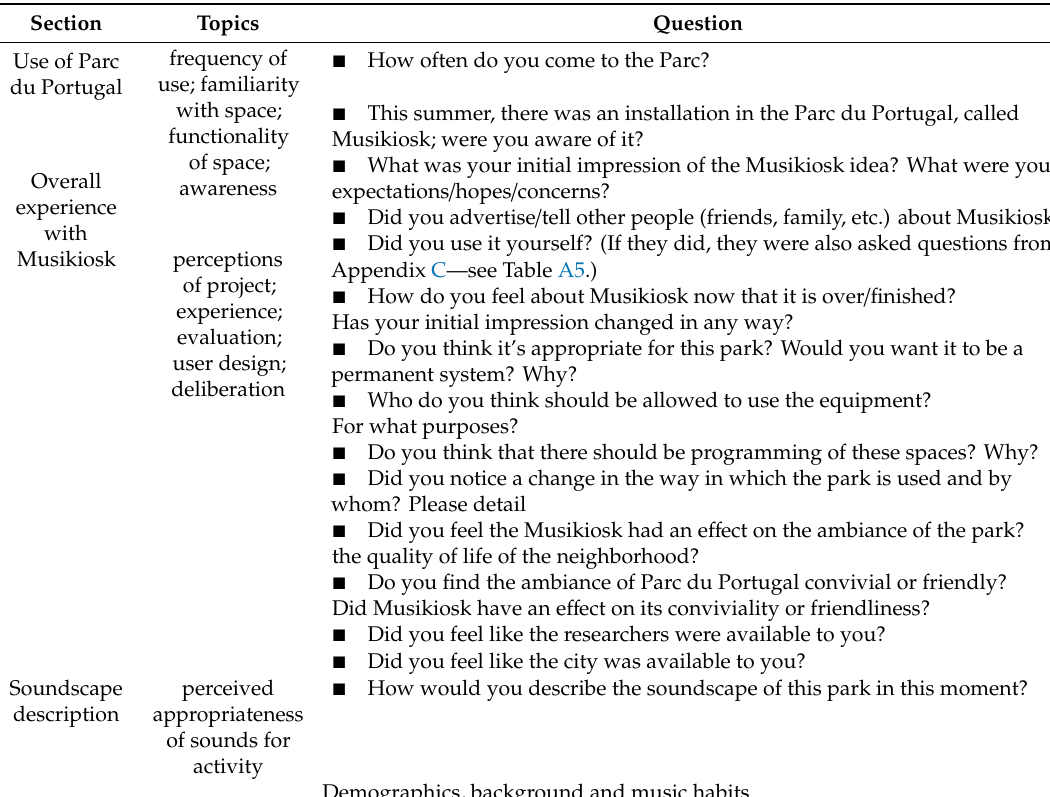
Table A4. Resident interview guide.